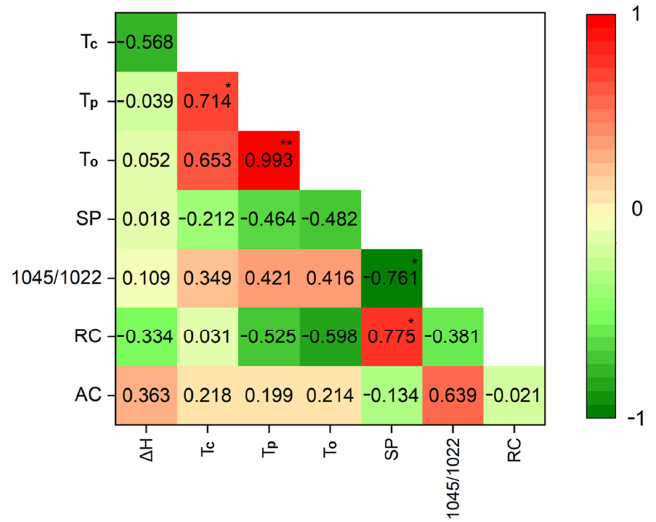
Figure 4. Heatmap plots of Pearson correlation coefficients between starch properties. r values are shown as a gradient from green to red, corresponding to from − 1 to 1. * and ** indicate signi fi cant di ff erence at p < 0.05 and p < 0.01, respectively ( n = 8). AC, amylose content; RC, relative crystallinity; 1045/1022, the ratio of absorbance 1045/1022 cm − 1 ; SP, swelling power; T o , onset temperature; T p : peak of gelatinization temperature; T c : conclusion temperature; Δ H: gelatinization enthalpy.